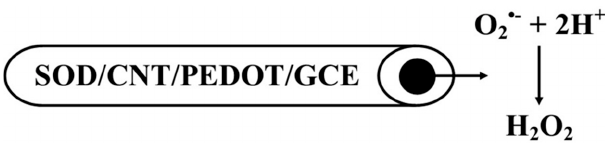
Figure 5. Schematic presentation of SOD biosensors based on PEDOT and CNT.